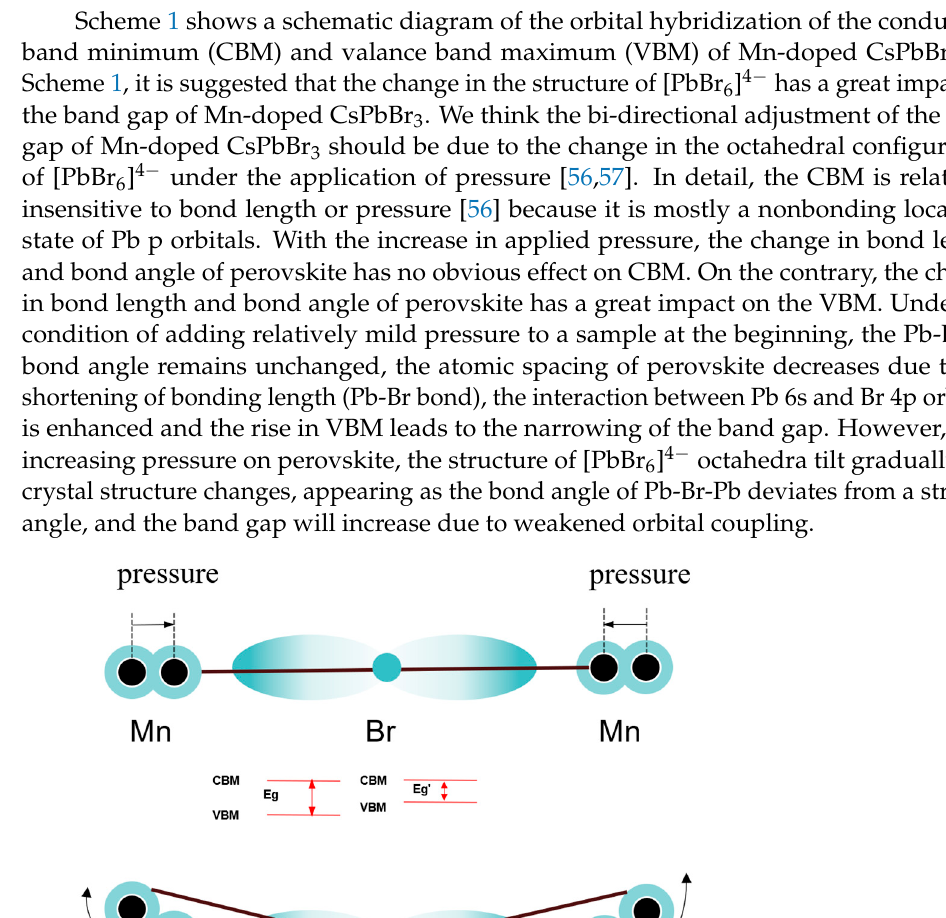
Figure 6. Curves of transient absorption peak energy-level changes (expressed in electron volts) of Mn-doped and undoped CsPbBr 3 versus pressure.